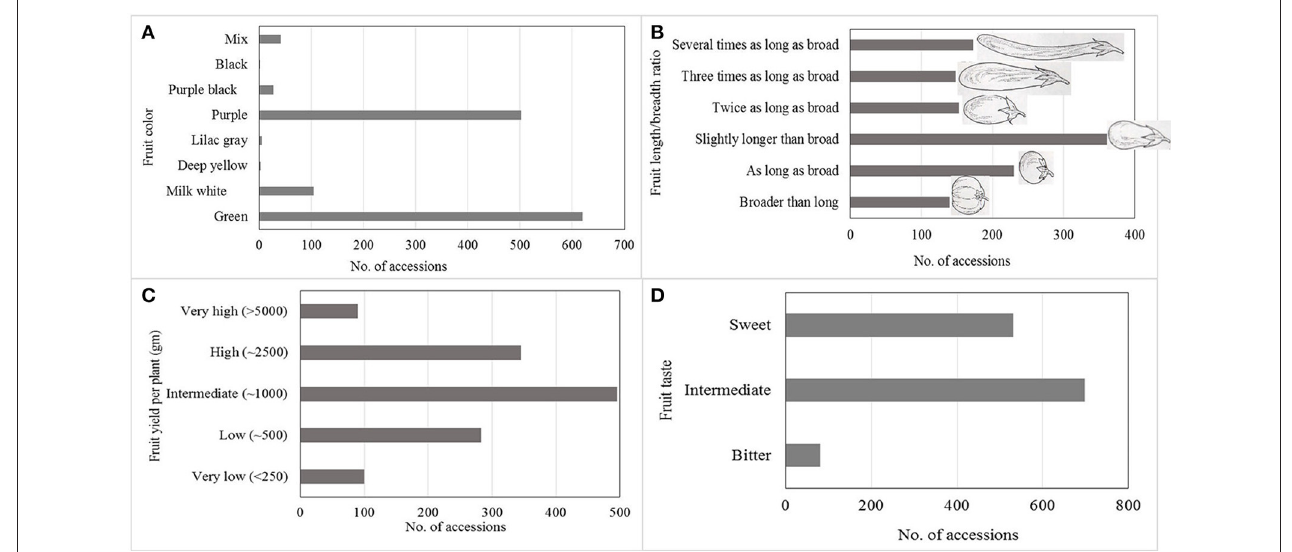
FIGURE 2 | Horticultural characteristics of more than 1,300 accessions of Solanum melongena summarized and based on information available in AVGRIS (2017): (A) Fruit color, (B) Fruit length, (C) Fruit yield per plant, and (D) Fruit taste.